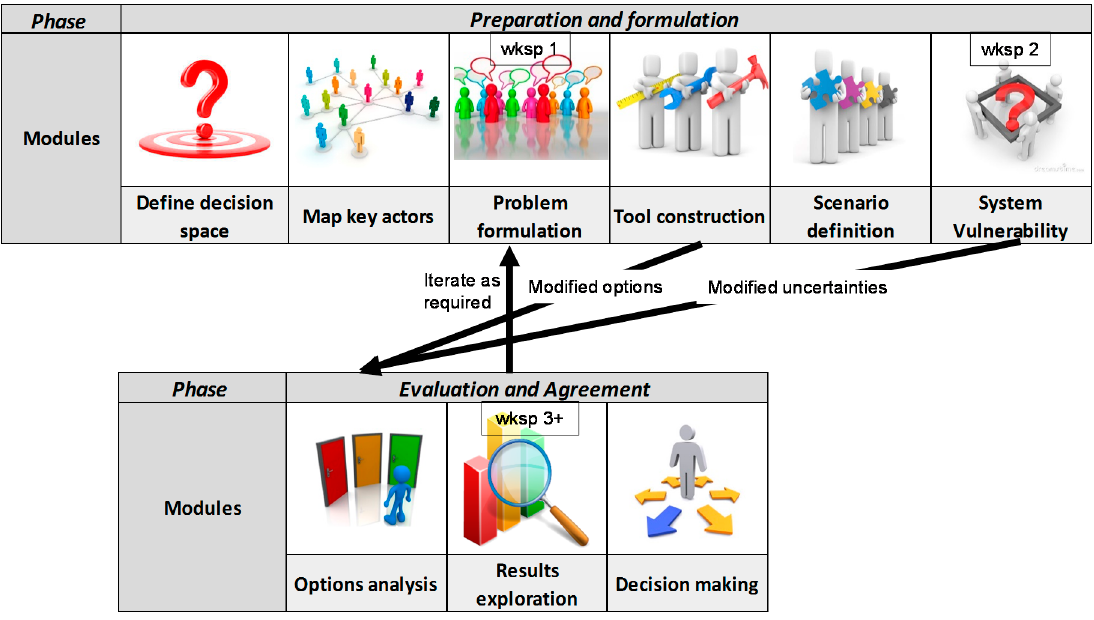
Figure 3. Steps within the Robust Decision Support (RDS) practice designed to lead stakeholders representing different water management constituencies though a process of highly participatory negotiations beginning with a problem formulation and culminating with a joint commitment to implement a consensus program of action. Potential iterative loops back to the initial problem formulation can follow model results exploration. Adjustments in the assumed future uncertainties will require a new system vulnerability assessment, while adjustments to the management options under consideration can be accommodated without generating a new vulnerability baseline. The timing of stakeholder workshops within the process is indicated.